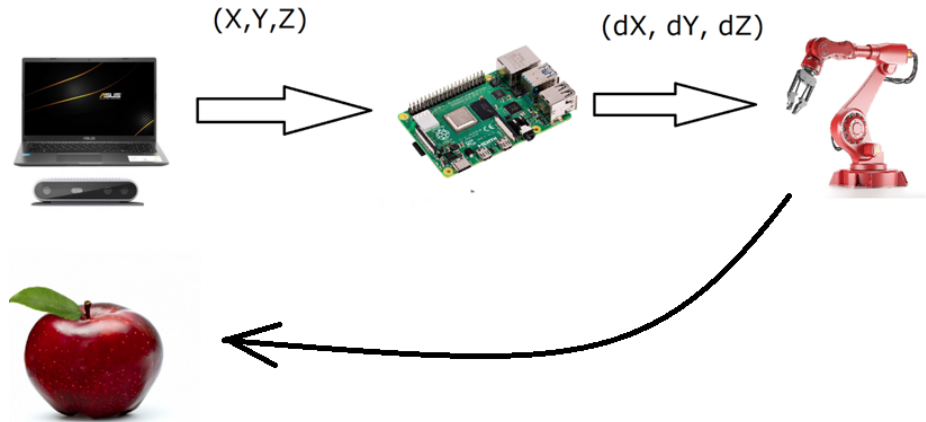
Figure 5. Scheme of operation of the manipulator.